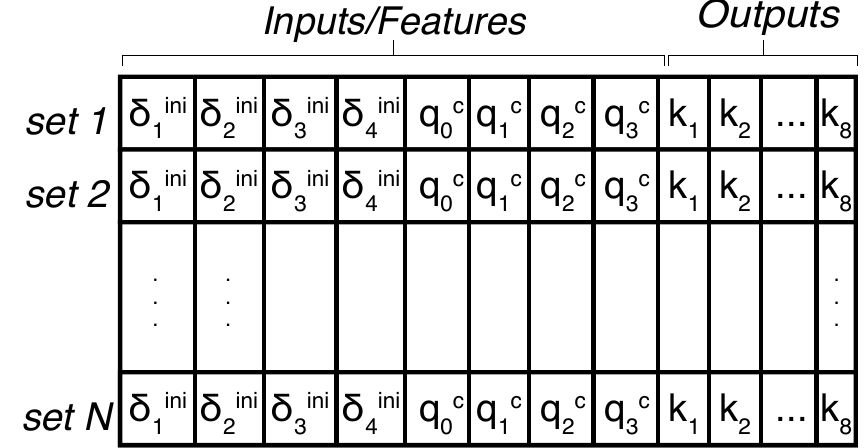
Figure 3. Data-set structure.